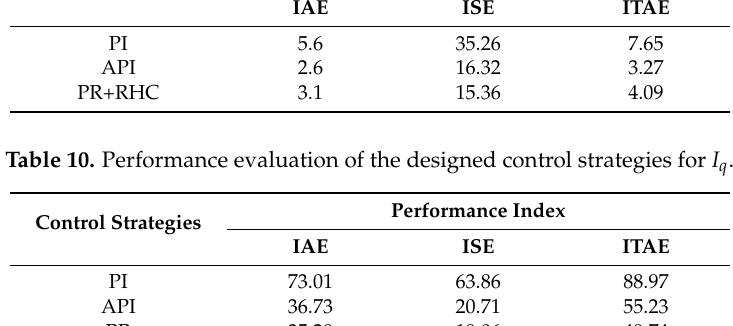
Table 10. Performance evaluation of the designed control strategies for I q .